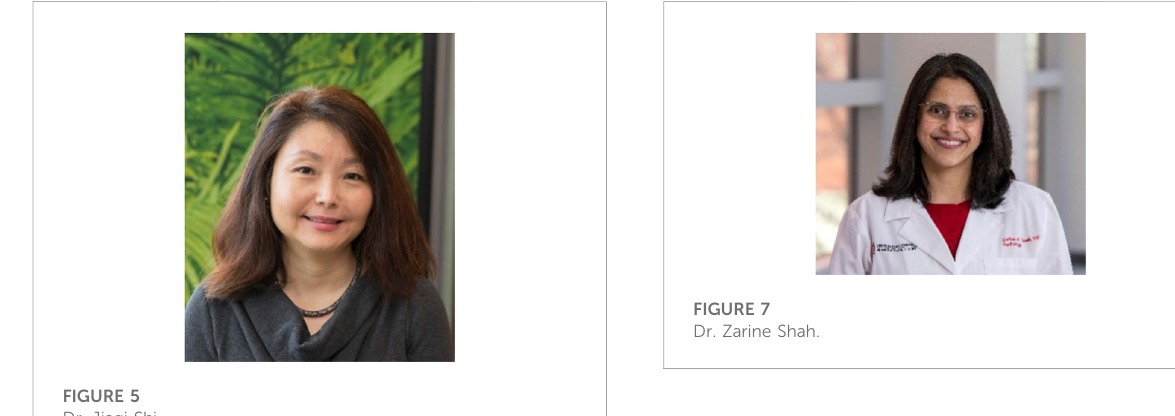
FIGURE 5 Dr. Jiaqi Shi.